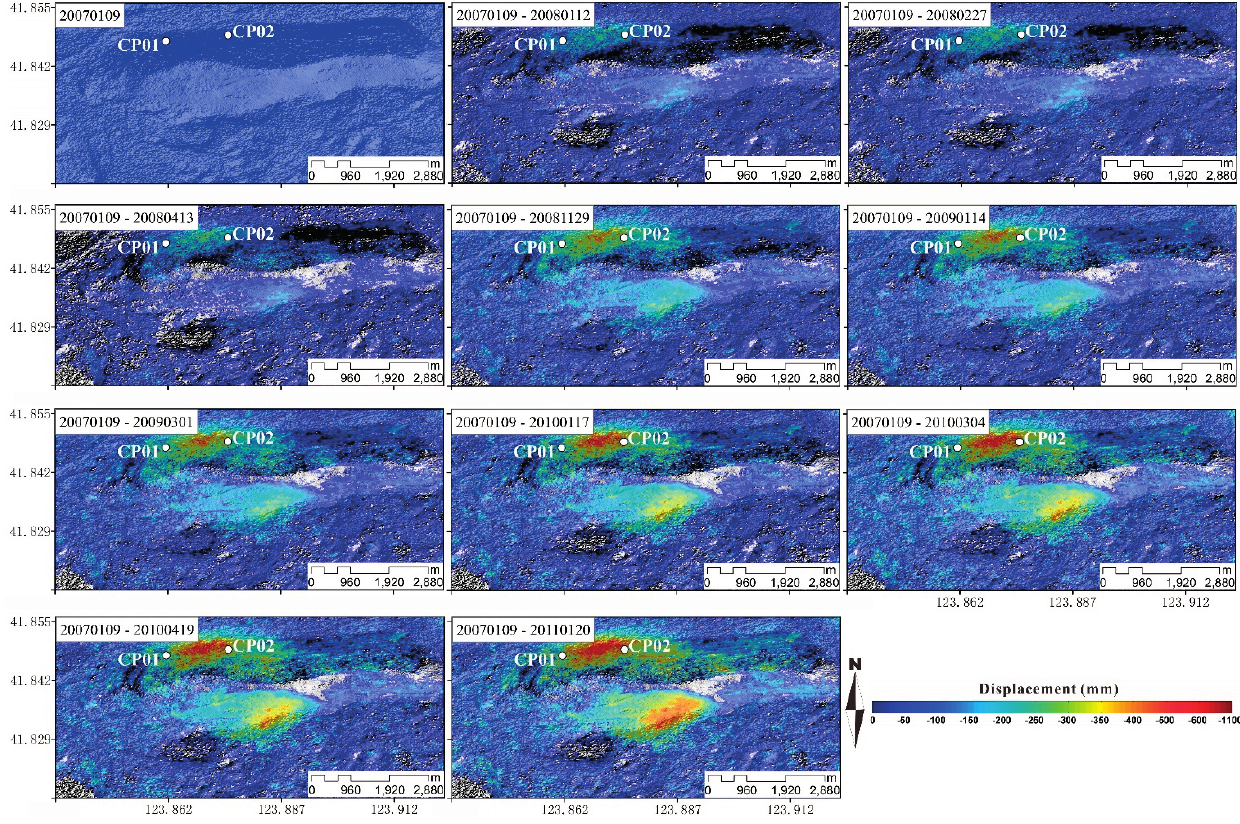
Figure 7. Vertical displacement maps in FWOPM obtained by DInSAR-SBAS approach. The color represents the vertical displacements for each time period. CP01 and CP02 represent two locations of global positioning system (GPS) measurements. The background is a shaded relief map of SRTM